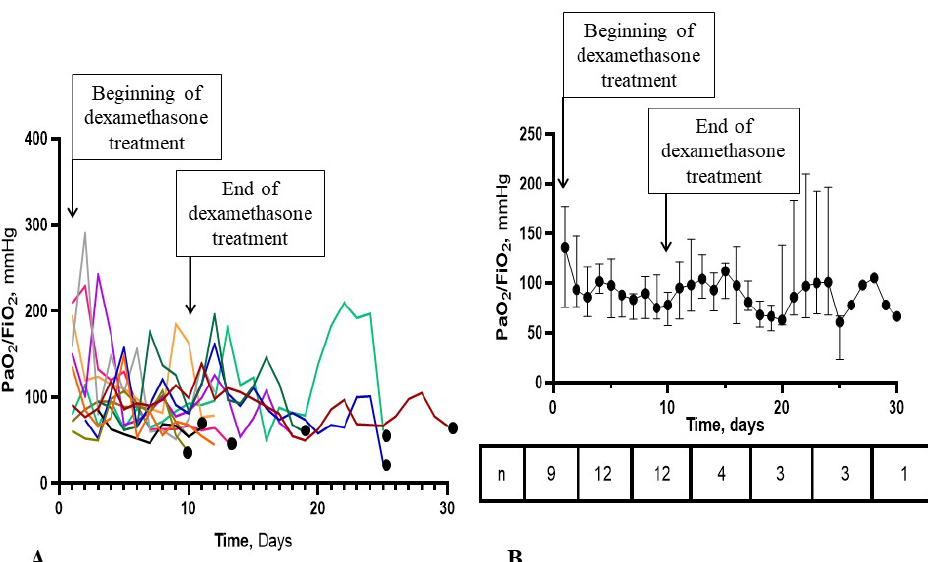
Figure 2. Individual and median PaO 2 /FiO 2 ratios from corticosteroid initiation to ECMO implementation in the 12 patients included in the ECMO-after group. Panel ( A ) represents PaO 2 /FiO 2 curves in individual patients. Data are missing in 3 patients on day 1. Curves end the day of ECMO implementation. Black dots identify patients with a diagnosis of bacterial pneumonia 48h before or after the day of ECMO initiation. Panel ( B ) represents median values and interquartile ranges as vertical bars. Numbers at the bottom represent the number of patients with available data. After day 10, the number of patients decreased as ECMO was initiated and only PaO 2 /FiO 2 ratios in ECMO-free patients were represented. The beginning and the end of corticosteroid treatment are shown by the corresponding arrows in both panels.